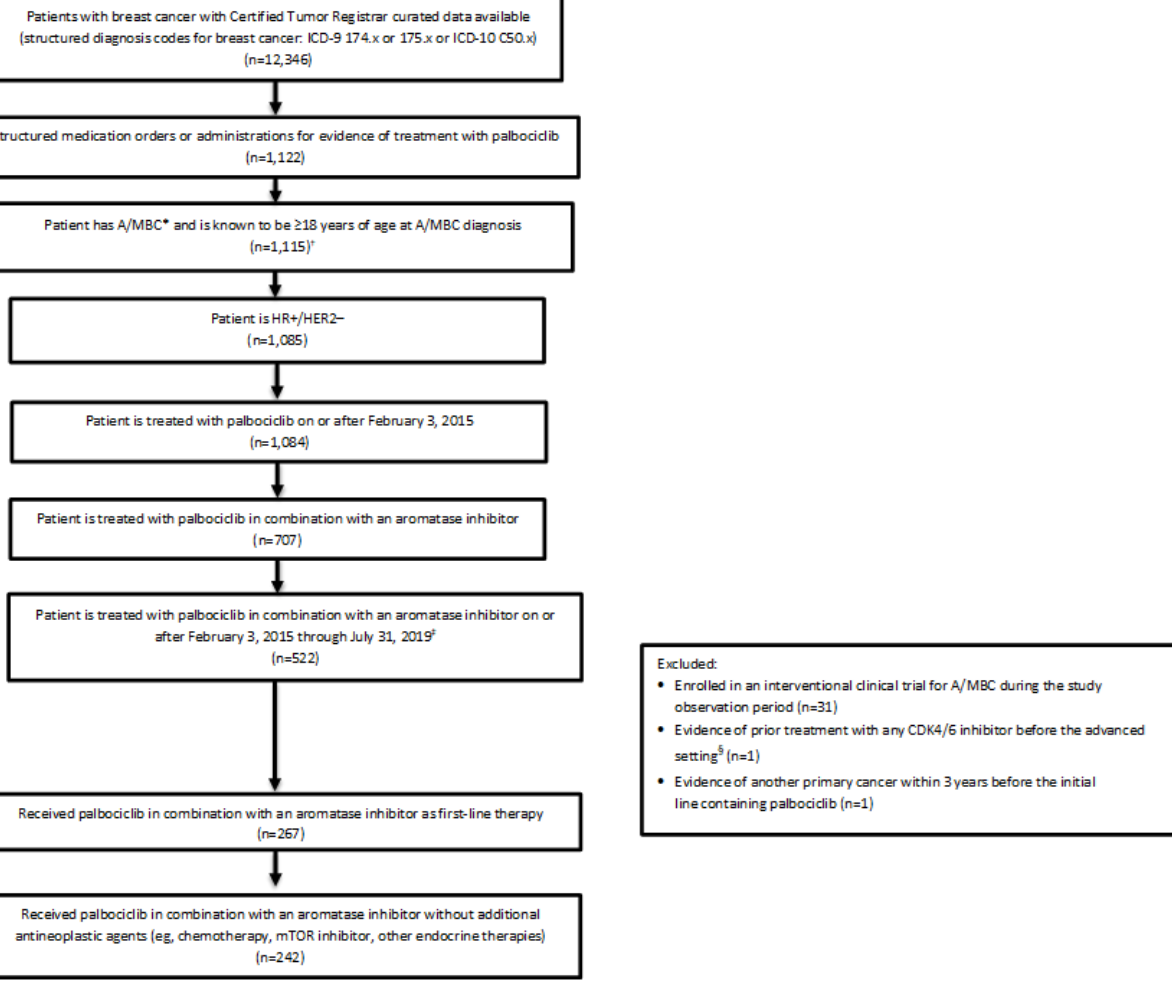
Figure 1. Patient attrition flowchart. A/MBC = advanced/metastatic breast cancer; CDK4/6 = cyclin- dependent kinase 4/6; HR+/HER2− = hormone receptor‒positive/human epidermal growth factor receptor 2‒negative; ICD-9/-10 = International Classification of Diseases, Ninth/Tenth Revision; mTOR = mechanistic target of rapamycin. * Advanced breast cancer defined as stage IIIb or IIIc or